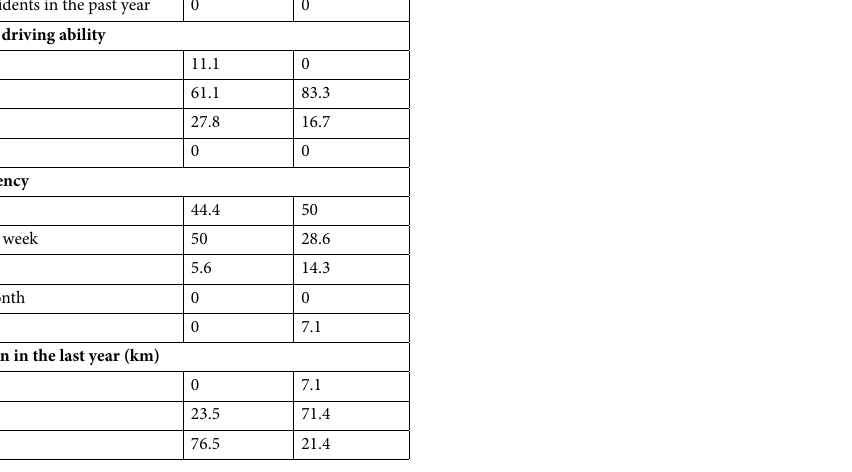
Table 2. Descriptive results of driving characteristics.